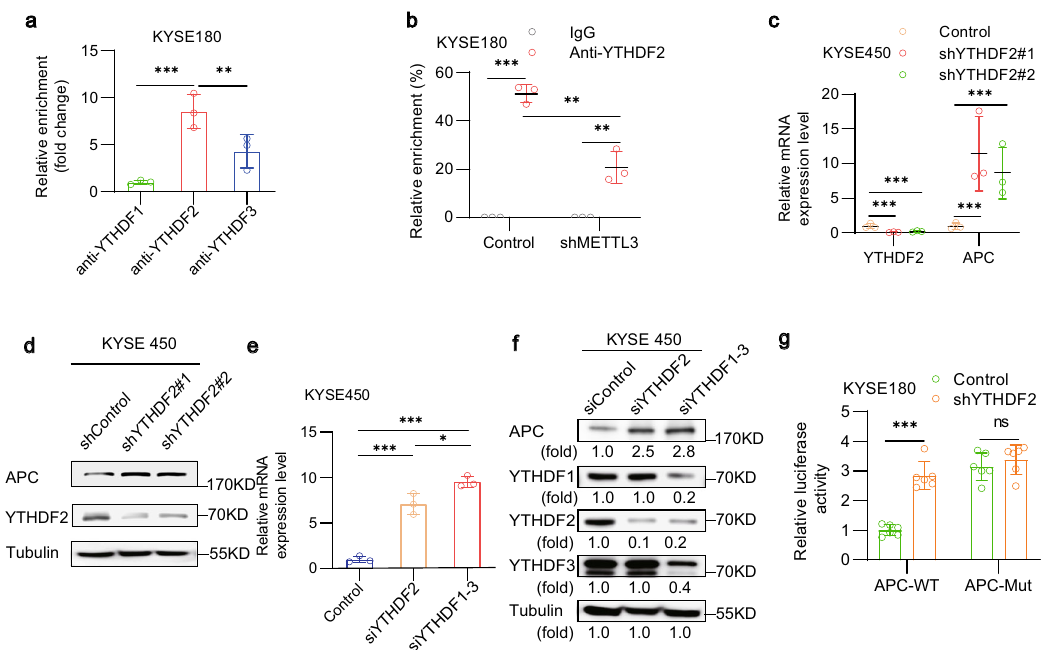
Fig. 5 METTL3-enhanced m 6 A of APC mRNA and subsequent binding of YTHDF2 suppresses APC expression. a RIP analyses of KYSE180 cells were performed with an anti-YTHDF1 or anti-YTHDF2, or anti-YTHDF3 antibody followed by qPCR analyses with primers against APC mRNA. Data represent the means ± SD of triplicate samples. *** p = 0.0006 (left), ** p = 0.0092 (right) based on two-tailed Student ’ s t -test. b KYSE180 cells were transfected with or without a vector expressing METTL3 shRNA. RIP analyses were performed with an anti-YTHDF2 antibody followed by qPCR analyses with primers against APC mRNA. Data represent the means ± SD of triplicate samples. *** p = 1.85E − 05 (left), ** p = 0.0023 (middle) and 0.0056 (right) based on two-tailed Student ’ s t -test. c KYSE450 cells were transfected with or without a vector expressing YTHDF2 shRNA. The relative mRNA expression levels of APC were measured using quantitative PCR. Data represent the means ± SD of triplicate samples. *** p = 0.0006, 0.0009, 5.58E − 05 and 0.0007 (left to right) based on two-tailed Student ’ s t -test. d KYSE450 cells were transfected with or without YTHDF2 shRNA. Immunoblotting analyses were performed with the indicated antibodies for three times with similar results. e KYSE180 cells were transfected with or without a YTHDF2 siRNA or combination of YTHDF1 – 3 siRNAs. The relative mRNA expression levels of APC were measured using quantitative PCR. Data represent the means ± SD of triplicate samples. *** p = 9.33E − 04 (left) and 2.99E − 05 (right), * p = 0.031 based on two-tailed Student ’ s t -test. f KYSE180 cells were transfected with or without results. g KYSE180 cells expressing luciferase reporter genes fused with or without the wild-type (WT) or mutated m6A nucleotides from APC genes were transfected with or without a vector expressing YTHDF2 shRNA. The relative luciferase activity after normalization to the shControl group is shown. Data represent the means ± SD of triplicate samples. *** p = 3.94E − 06 based on two-tailed Student ’ s t -test. ns, not signi fi cant. Source data are provided as a Source Data fi